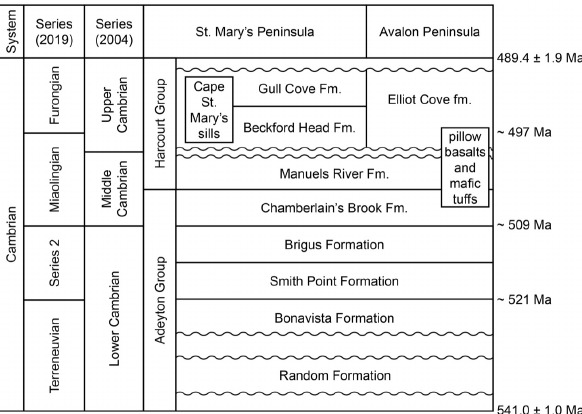
Figure 2. Cambrian stratigraphy of the western Avalon Penin- sula, compiled after King (1988), Fletcher (2006) and Austermann (2016). Subdivision of the Cambrian after Peng et al.